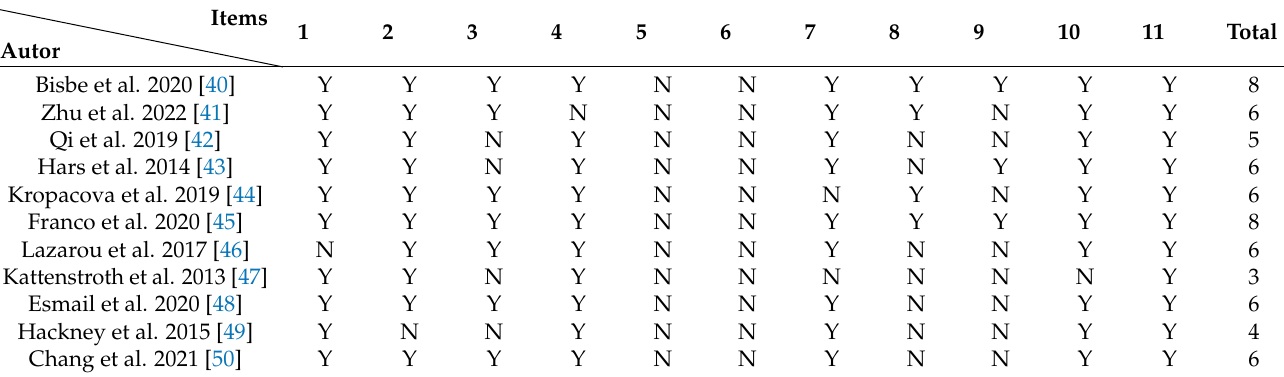
Table 1. Methodological quality of the articles included.